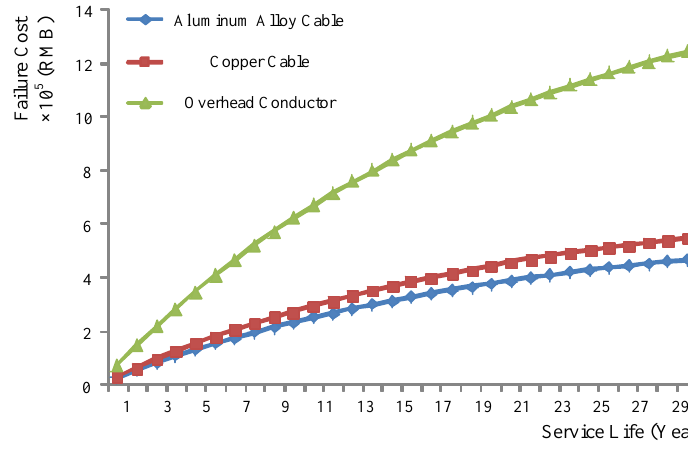
Figure 10. Failure cost during 30 years in Case 1.